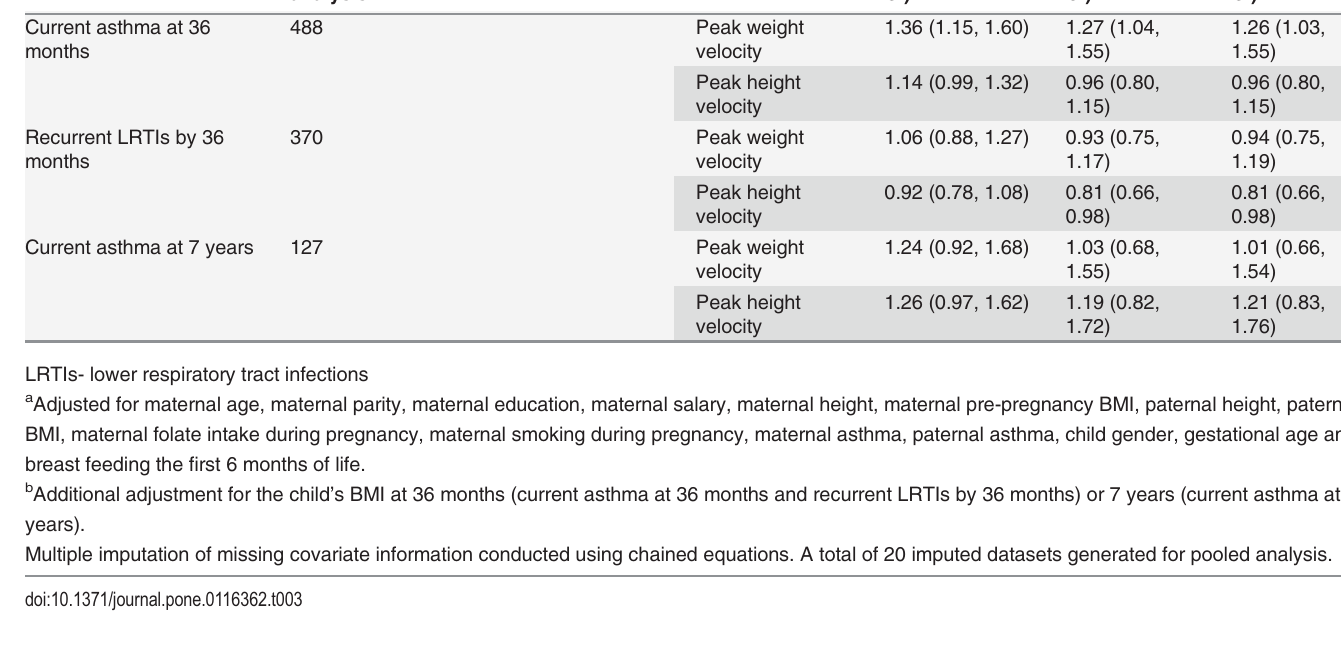
Table 3. Sibling pair analysis of the associations of one standard deviation increase in peak weight and height velocity the fi rst 36 months of life with development of respiratory disorders. Outcome Number of discordant sibling pairs in